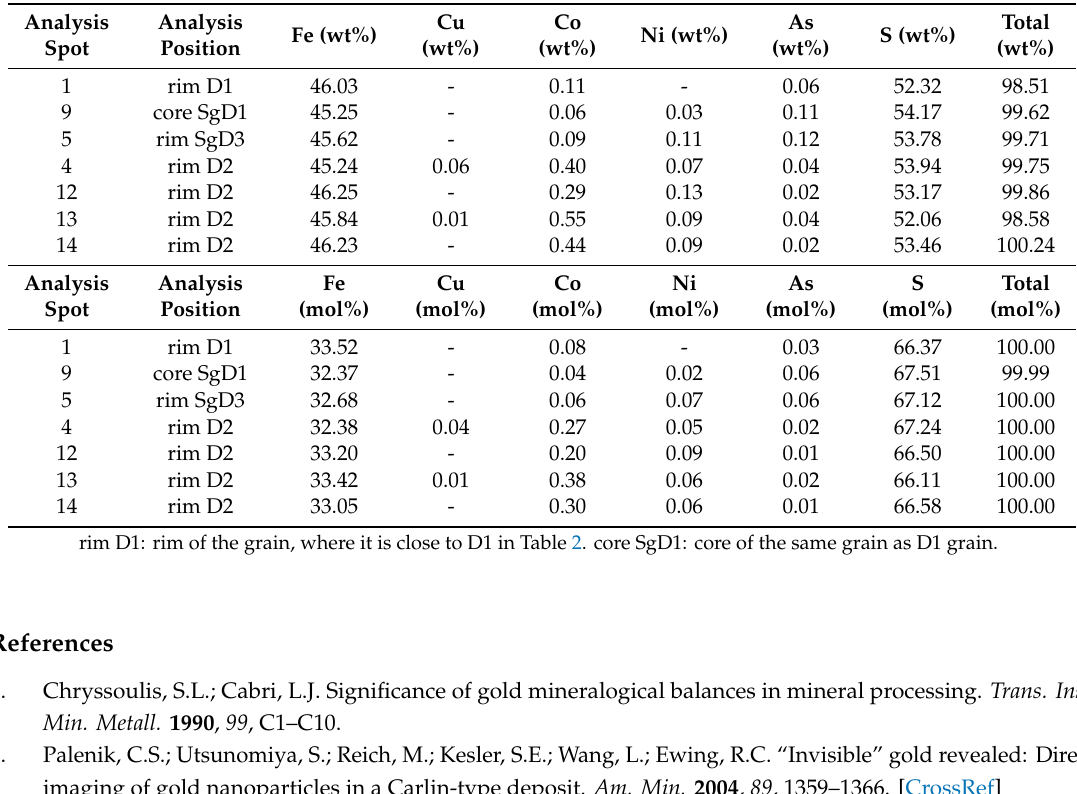
Table A3. Results of the EPMA analysis of pyrite from the KDC West